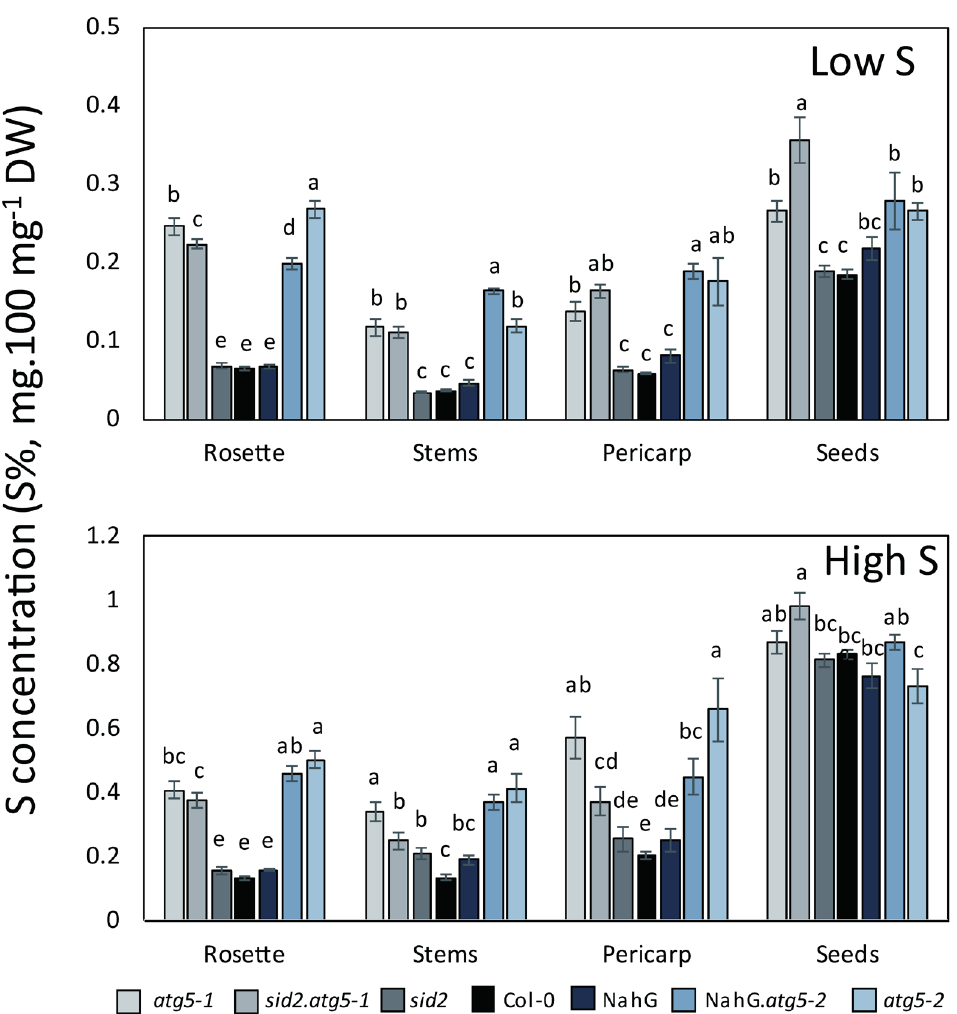
Figure 3. Sulphur concentrations are higher in the atg5 autophagy mutants than in the control lines under both low S and high S. S concentrations (S% as mg.100 mg -1 DW) in the rosette, stem, pericarp and seeds of atg5 mutants ( atg5-1 , atg5-2 , atg5-1.sid2 , atg5-2. NahG) and control lines (Col-0, sid2 and NahG) were determined on plants grown under low S and high S. Data are the adjusted means and SD from two biological repeats with six plants each. The different letters indicate values significantly different at p < 0.05 (n = 12), as determined using an ANOVA Newman–Keuls (SNK) comparison.